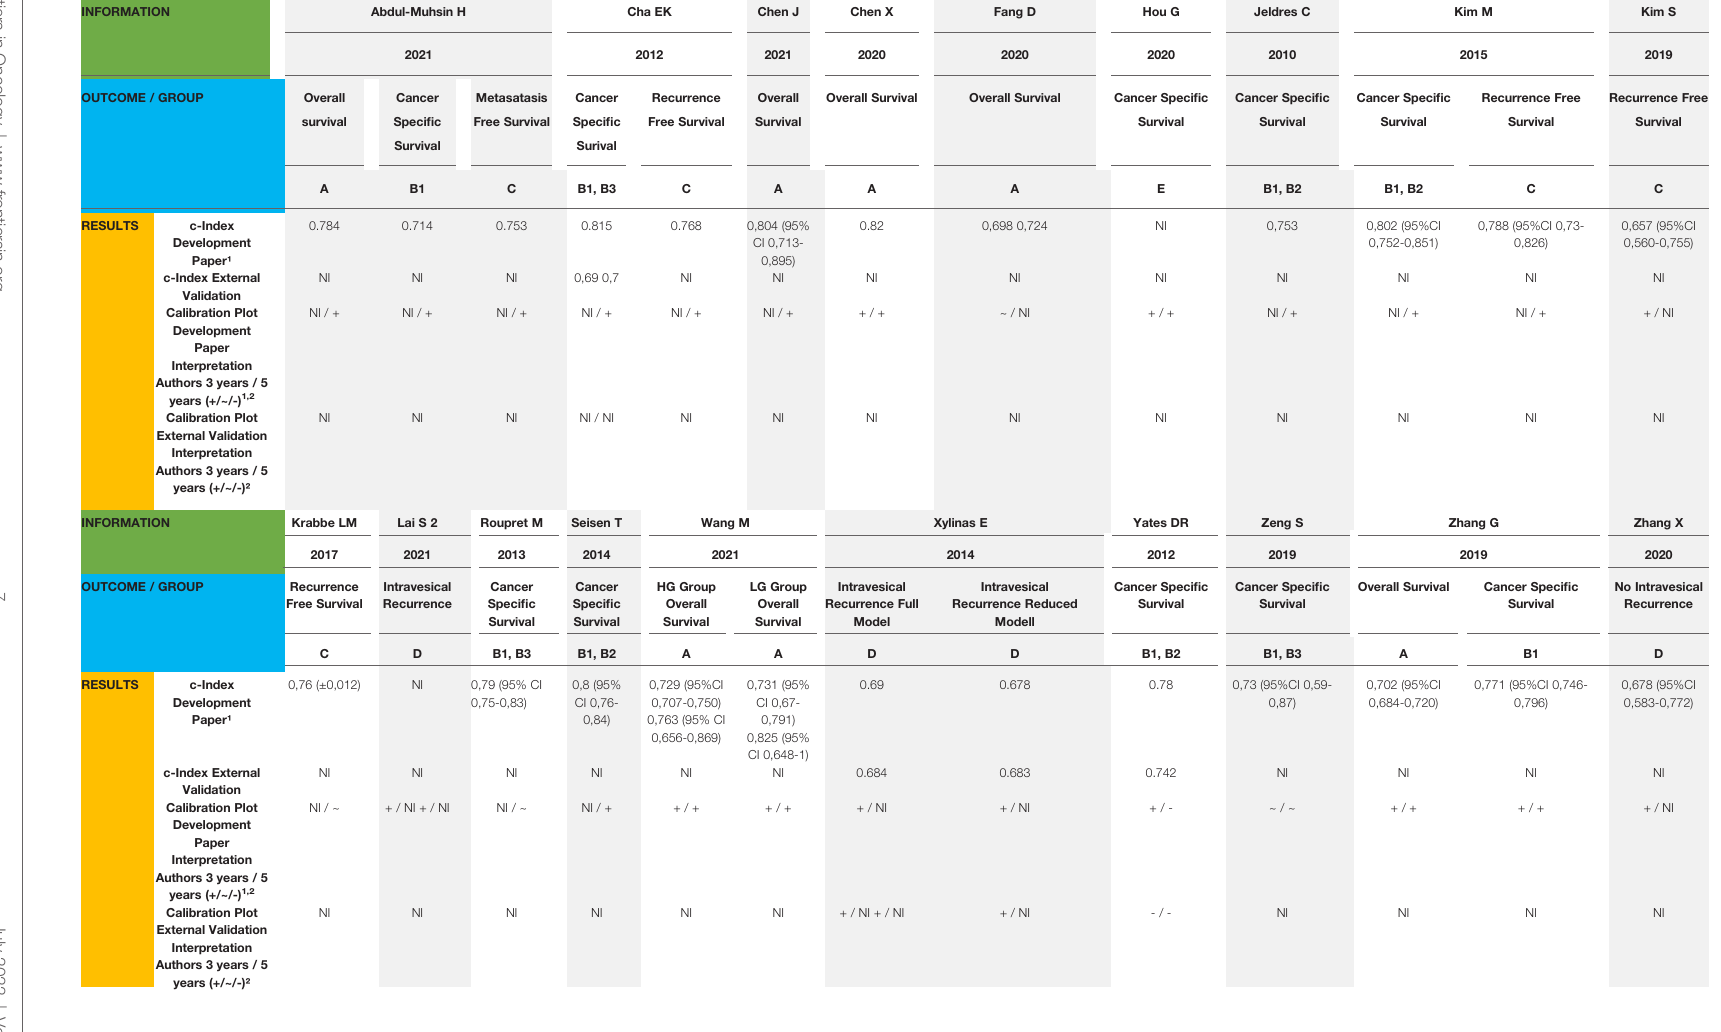
TABLE 2 | This table gives a detailed overview of the performance of the nomograms (discrimination = c-Index, and calibration = interpretation of the calibration plot) on development and validation